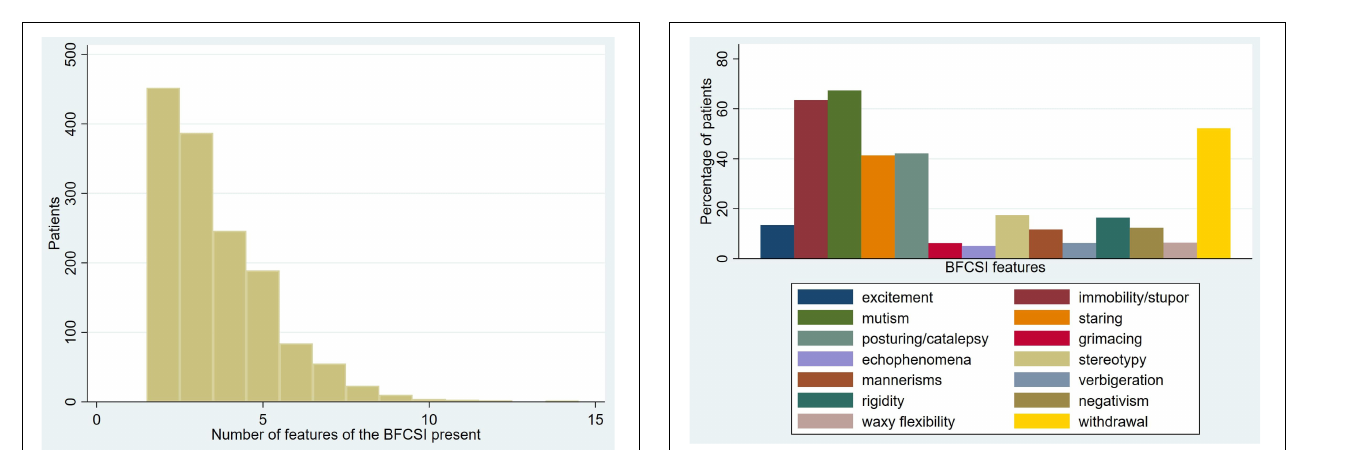
FIGURE 1 | Number of catatonic features per patient (measured at first episode).